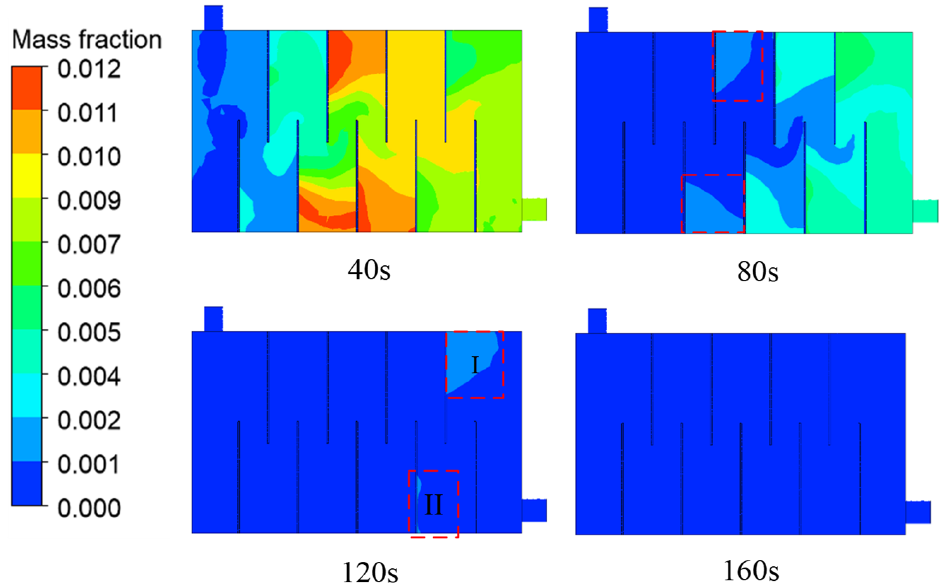
Figure 13. Contour plot of the YZ plane tracer concentration at x = 315 mm with time for the reactor (V = 2.6 m/s, P l = 490 mm, P s = 129.45 mm).